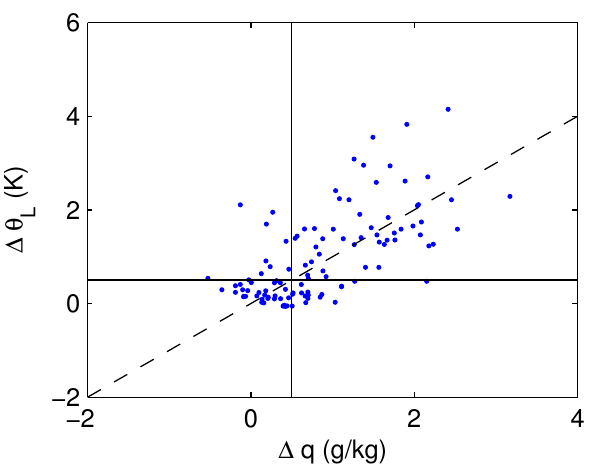
Fig. 3. Scatter plot of 1θ ‘ versus 1q with the “well-mixed” clas- sification indicated by the lower left box. The least-squares best linear fit passing through the origin is denoted by the dashed line.